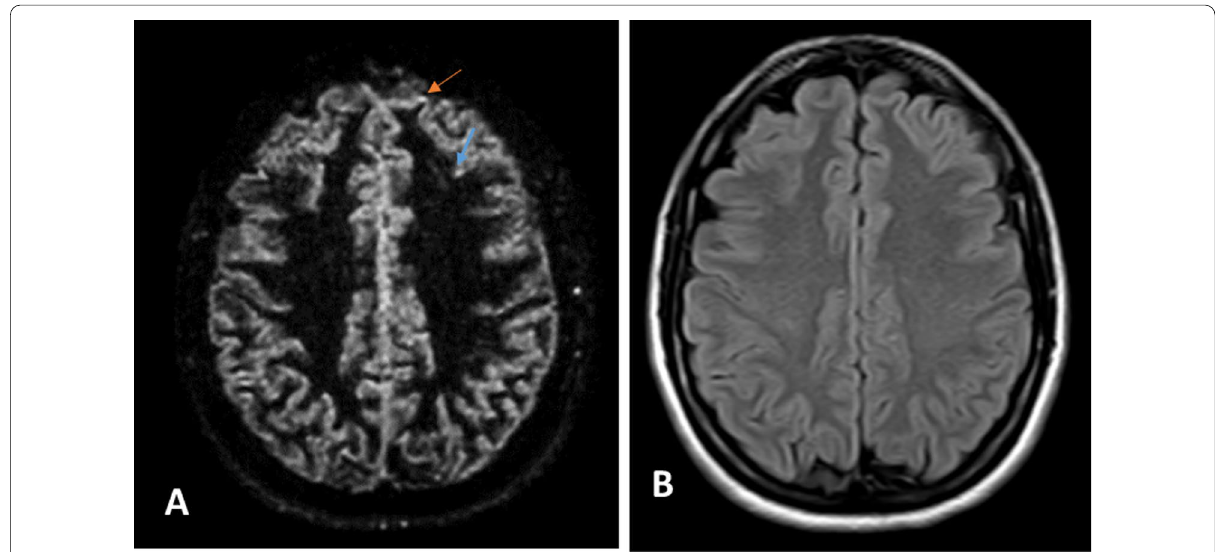
Fig. 3 A 29-year-old female patient with relapsing–remitting MS and EDSS score of 2. A Axial DIR clearly define the left frontal type 2 (blue arrow) and type 3 (orange arrow) cortical plaques. B Axial FLAIR at the same level didn’t reveal the lesions identified on the DIR